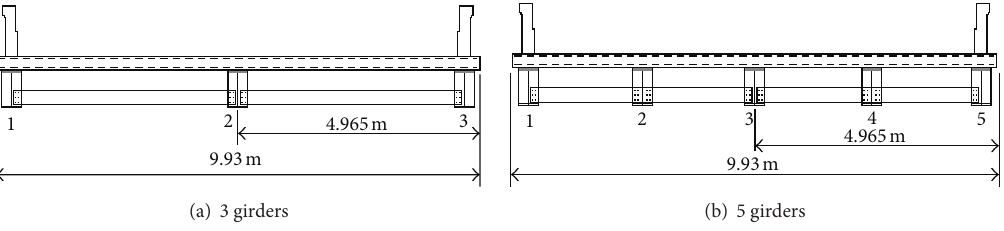
Figure 2: Cross-sections of the composite bridges.